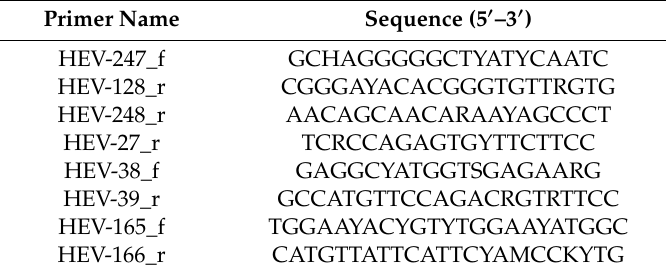
Table 1. Primers used for amplification of the RNA-dependent RNA-polymerase ( RdRp ) region and sequencing. HEV: hepatitis E